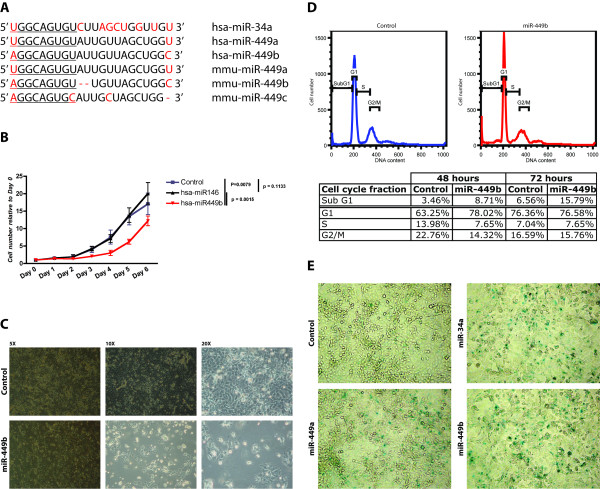
miR-449 is part of the miR-34 family and inhibits cell proliferation. A - miR-449 is part of the miR-34 family and is evolutionarily conserved. B - miR-449 re-introduction into human gastric cell lines (SNU638) inhibits cell proliferation (red line) compared to a scrambled control (blue line) and miR-146 control (black line). Error bars represent S.D. C - Visual inspection of cell proliferation inhibition and senescence-like phenotype upon miR-449 re-introduction into SNU638 cells (lower panel) compared to scrambled transfection control (upper panel). D - FACS cell cycle analysis showing sub-G1 accumulation of SNU638 cells 72 hours following miR-449 re-introduction (right histogram) compared to a scrambled transfection control (left histogram) The table shows cell accumulation in G1 fraction upon miR-449 re-introduction compared to scrambled RNA control at 48 hours post transfection, followed by a shift to the sub-G1 fraction at 72 hours post transfection indicative of cell death. E - Senescent phenotype of SNU638 cells upon miR-449 and miR-34a positive control re-introduction shown by acidic β-gal assay compared to RNA scrambled control.